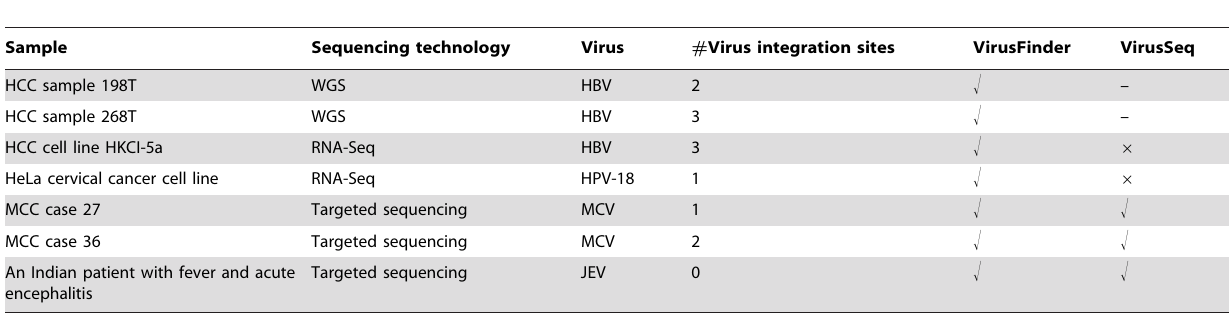
Table 1. Detection of viruses in seven NGS samples using VirusFinder and VirusSeq.